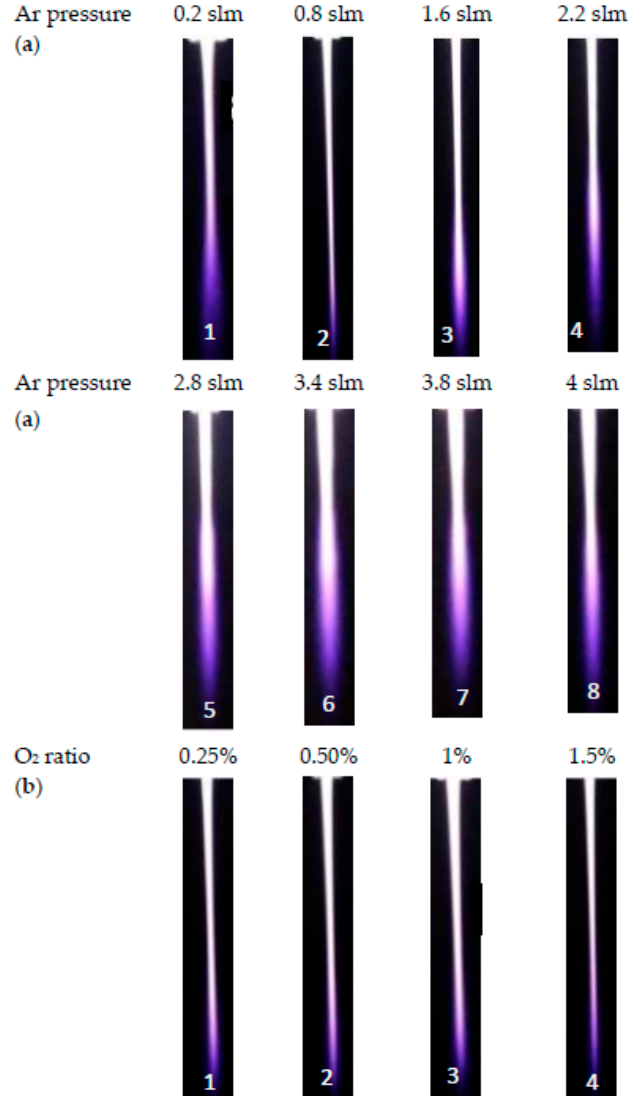
Figure 4. ( a ) Photo-imaging of the plasma jet lengths for argon discharge as a function of flow rate from 0.2 slm to 4 slm, and ( b ) Photo-imaging of the plasma jet lengths for oxygen ratio from 0.25% to 1.5%.